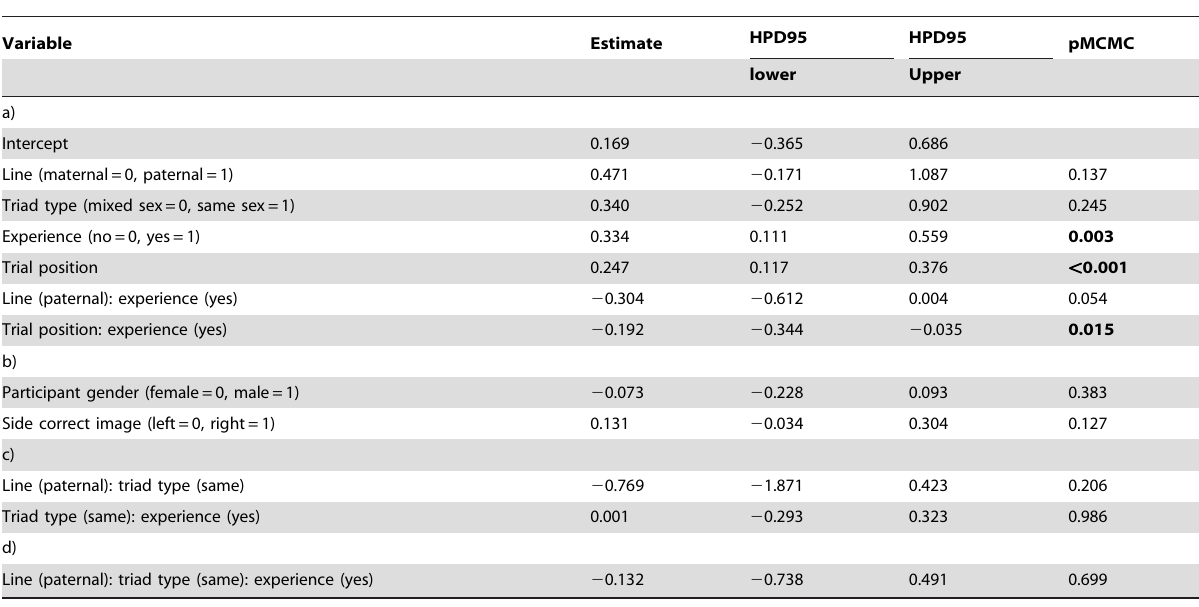
Table 3. Results of models examining performance in the kin discrimination task .